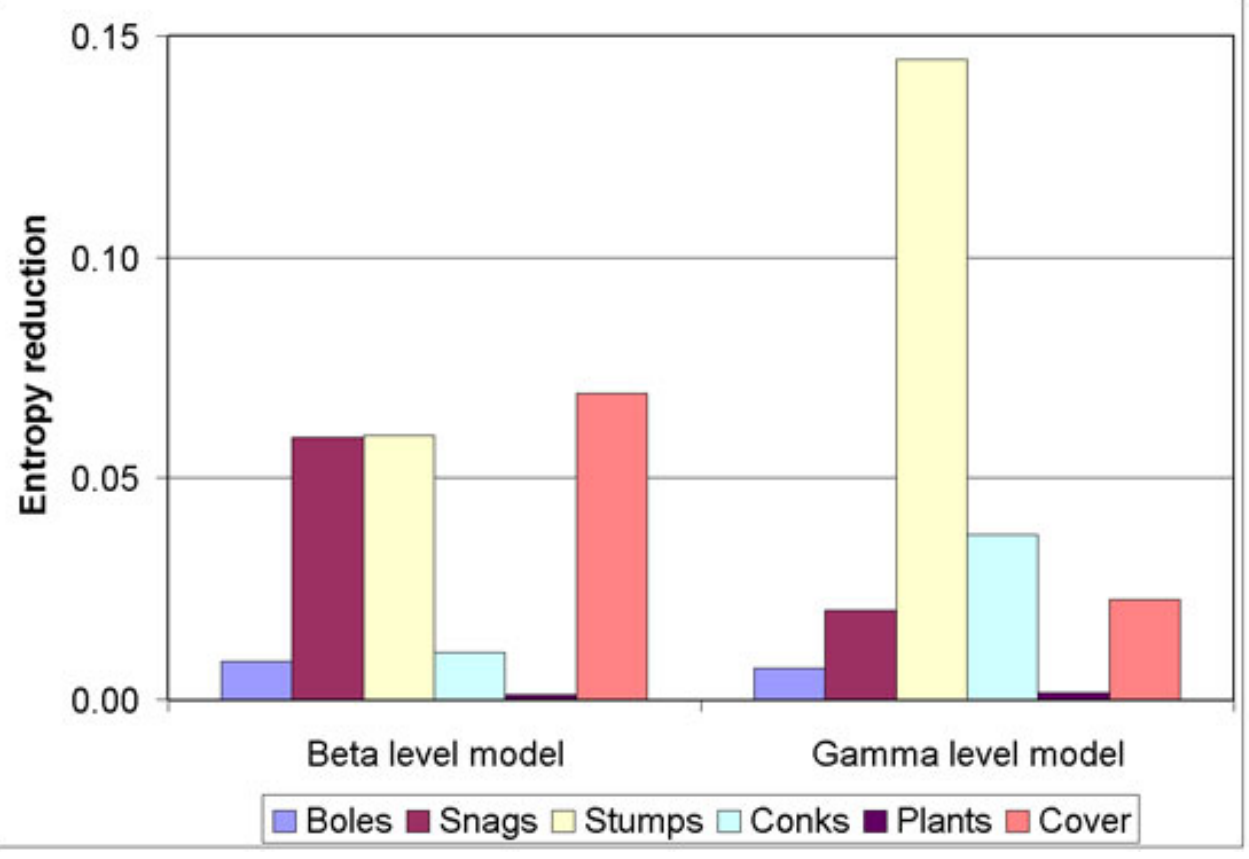
Fig. 5. Results of sensitivity analyses of the beta- and gamma-level models (Fig. 3). Bars represent the influence analyzed as entropy reduction. See text for calculation of each predictor variable on predicted presence or absence of the species; greater bar heights denote greater